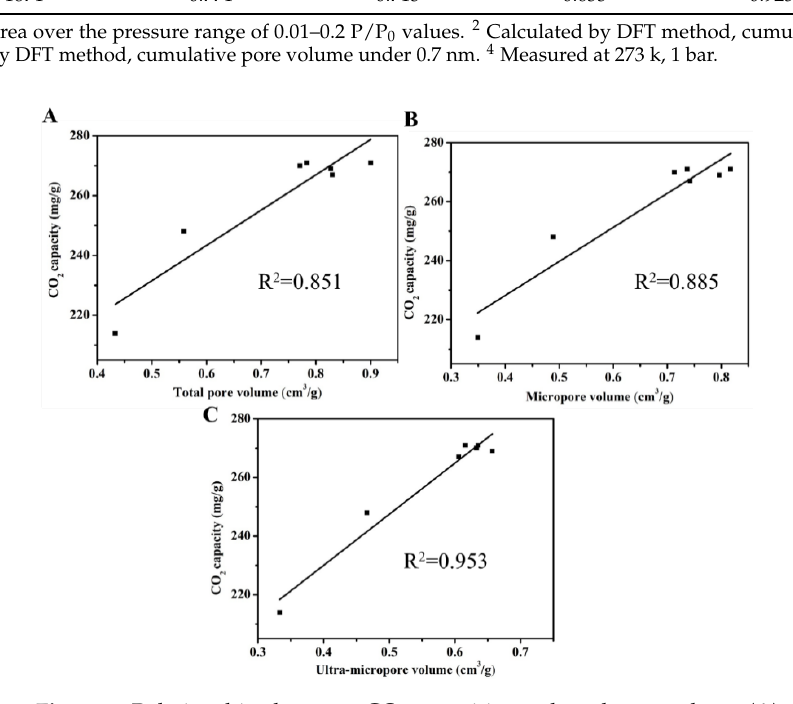
Figure 7. Relationships between CO 2 capacities and total pore volume ( A ), micropore volume ( B ), and ultra-micropore volume ( C ).